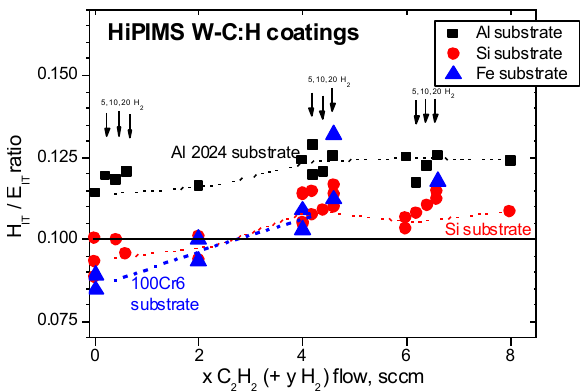
Figure 3. The dependence of H IMS W-C:H coatings on the substrate type at different acetylene (and hydrogen) additions. Note that the data-points corresponding to 5, 10 and 20 sccm H additions to the corresponding acetylene flows were intentionally shifted to emphasize the role of hydrogen